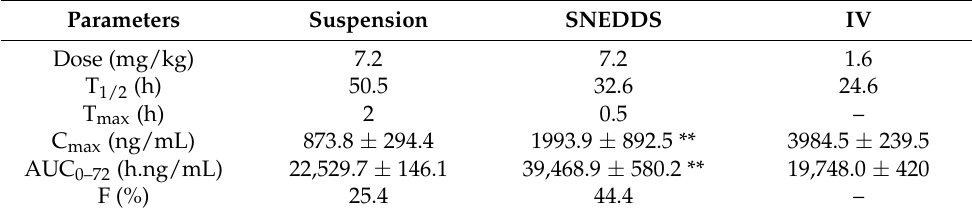
Figure 10. Plasma concentration time profiles of voxelotor after bolus intravenous injection (1.6 mg/kg) and oral administration of the suspension or SNEDDS (7.2 mg/kg) to rats. Data are expressed as the mean ± SD, n = 6. Table 6. Pharmacokinetic